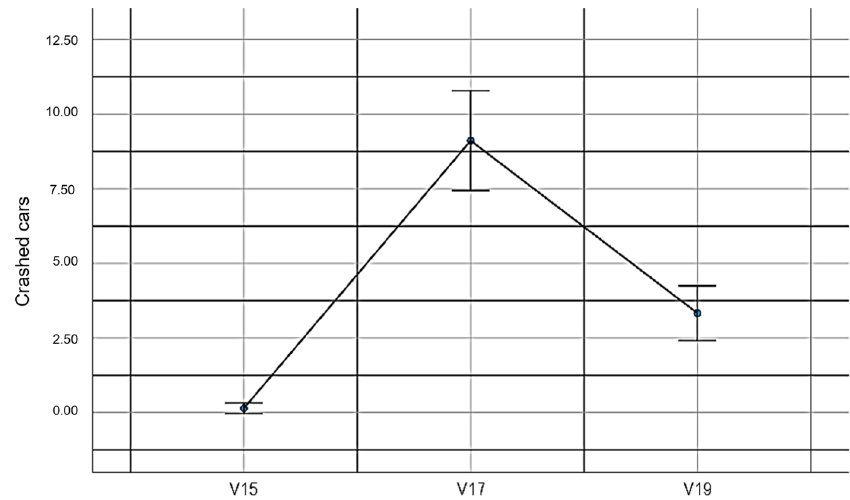
Figure 14. Number of crashed cars.